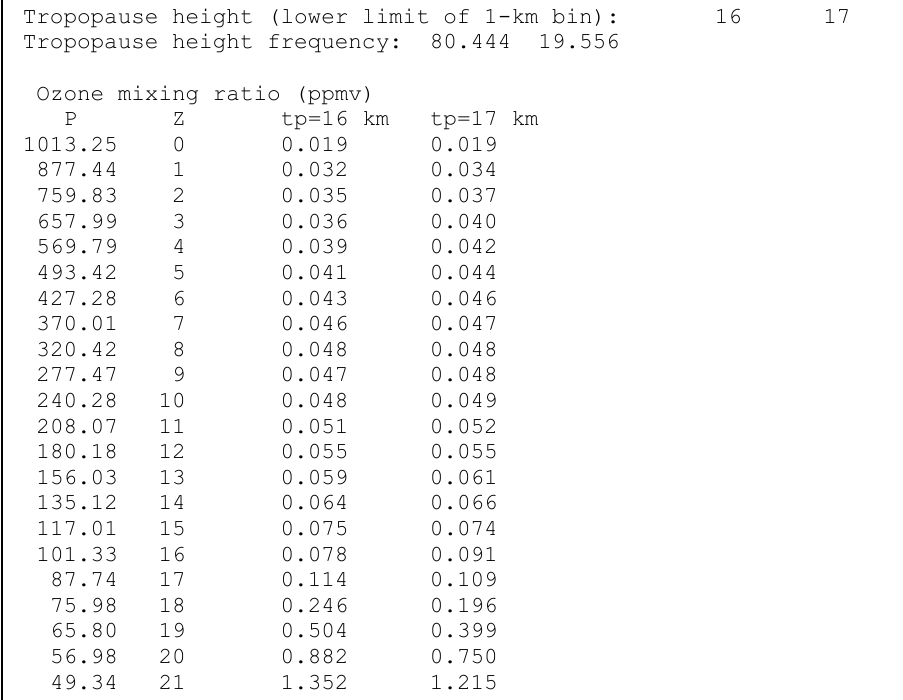
ozone profiles and their precision estimates (note that the rel- ative a priori uncertainty was the same in all